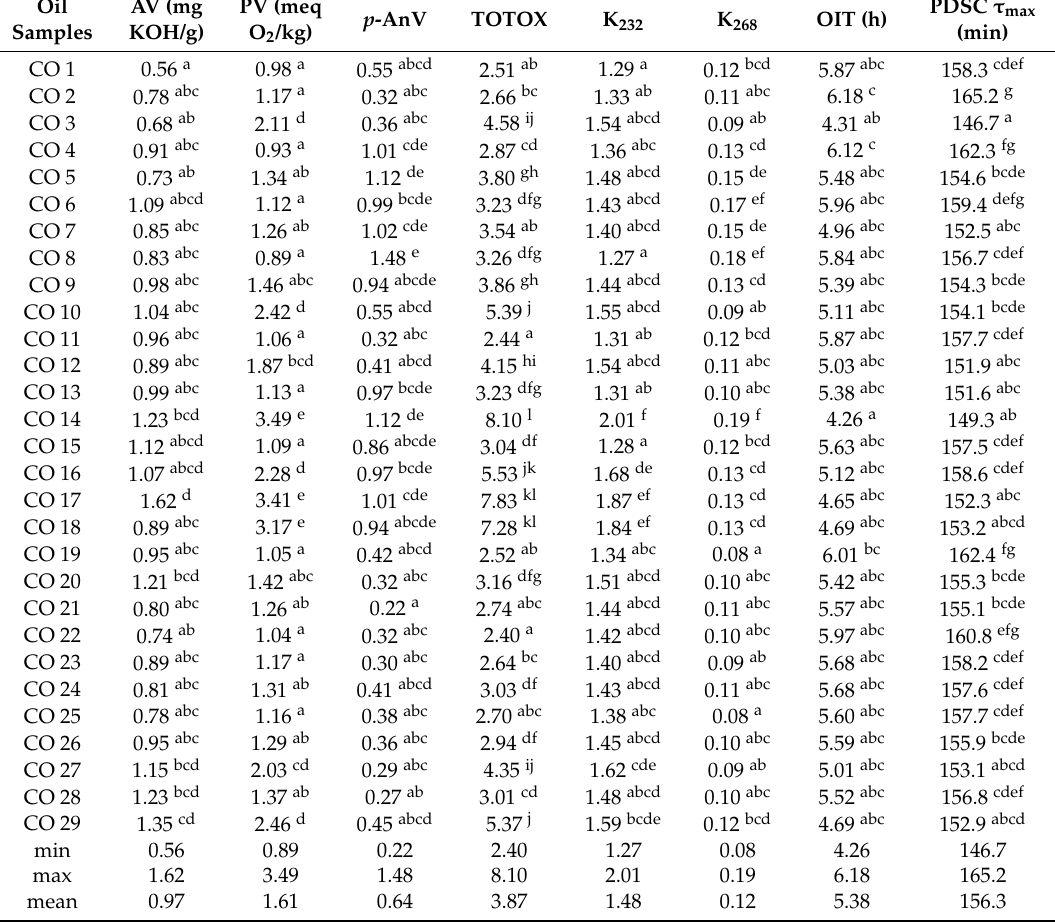
Table 1. Physicochemical quality parameters and oxidative stability of camelina